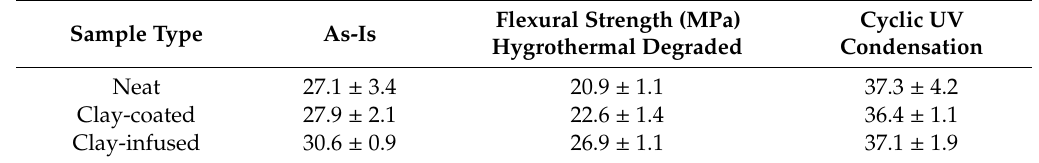
Table 1. Flexural strength of carpet